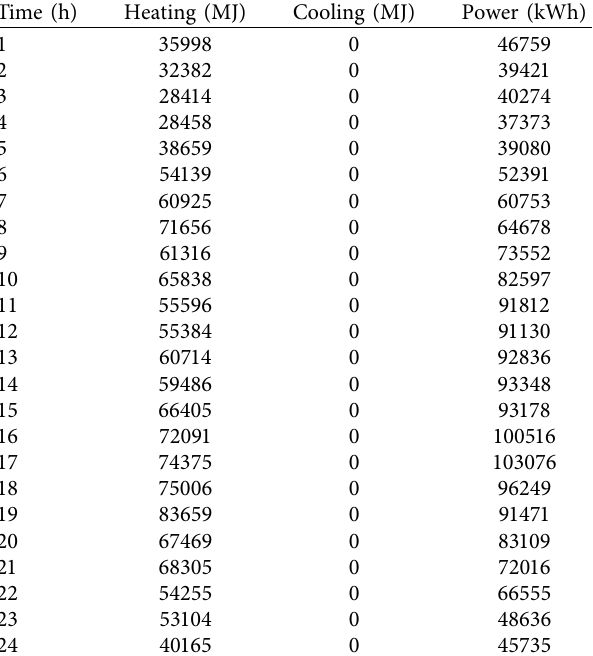
Table 2: Energy demand of winter typical day.